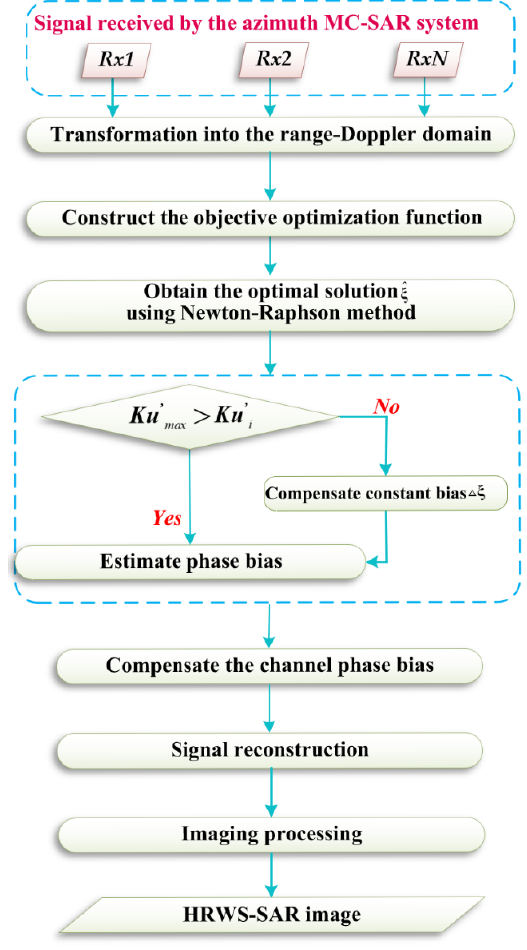
Figure 4. The flow chart of the proposed approach.